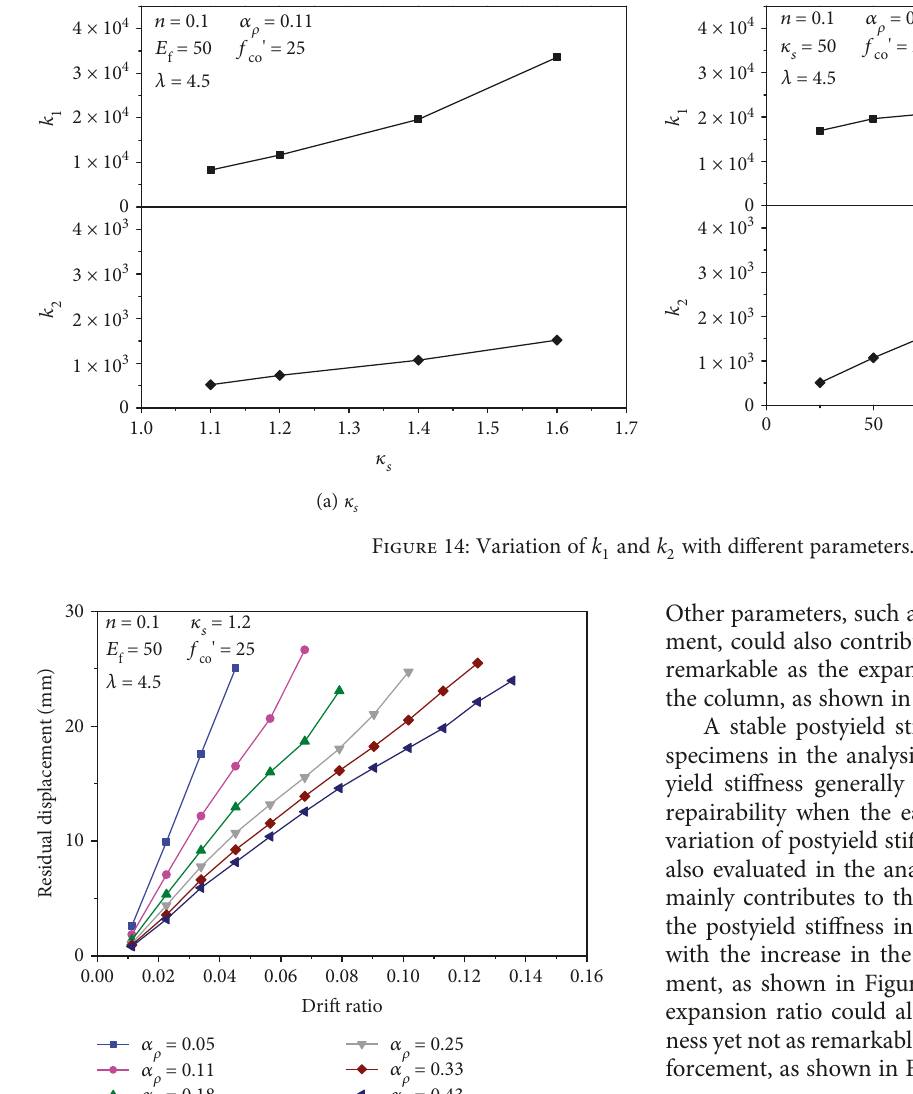
Figure 15: Variation of residual displacement with drift ratio along with α ρ